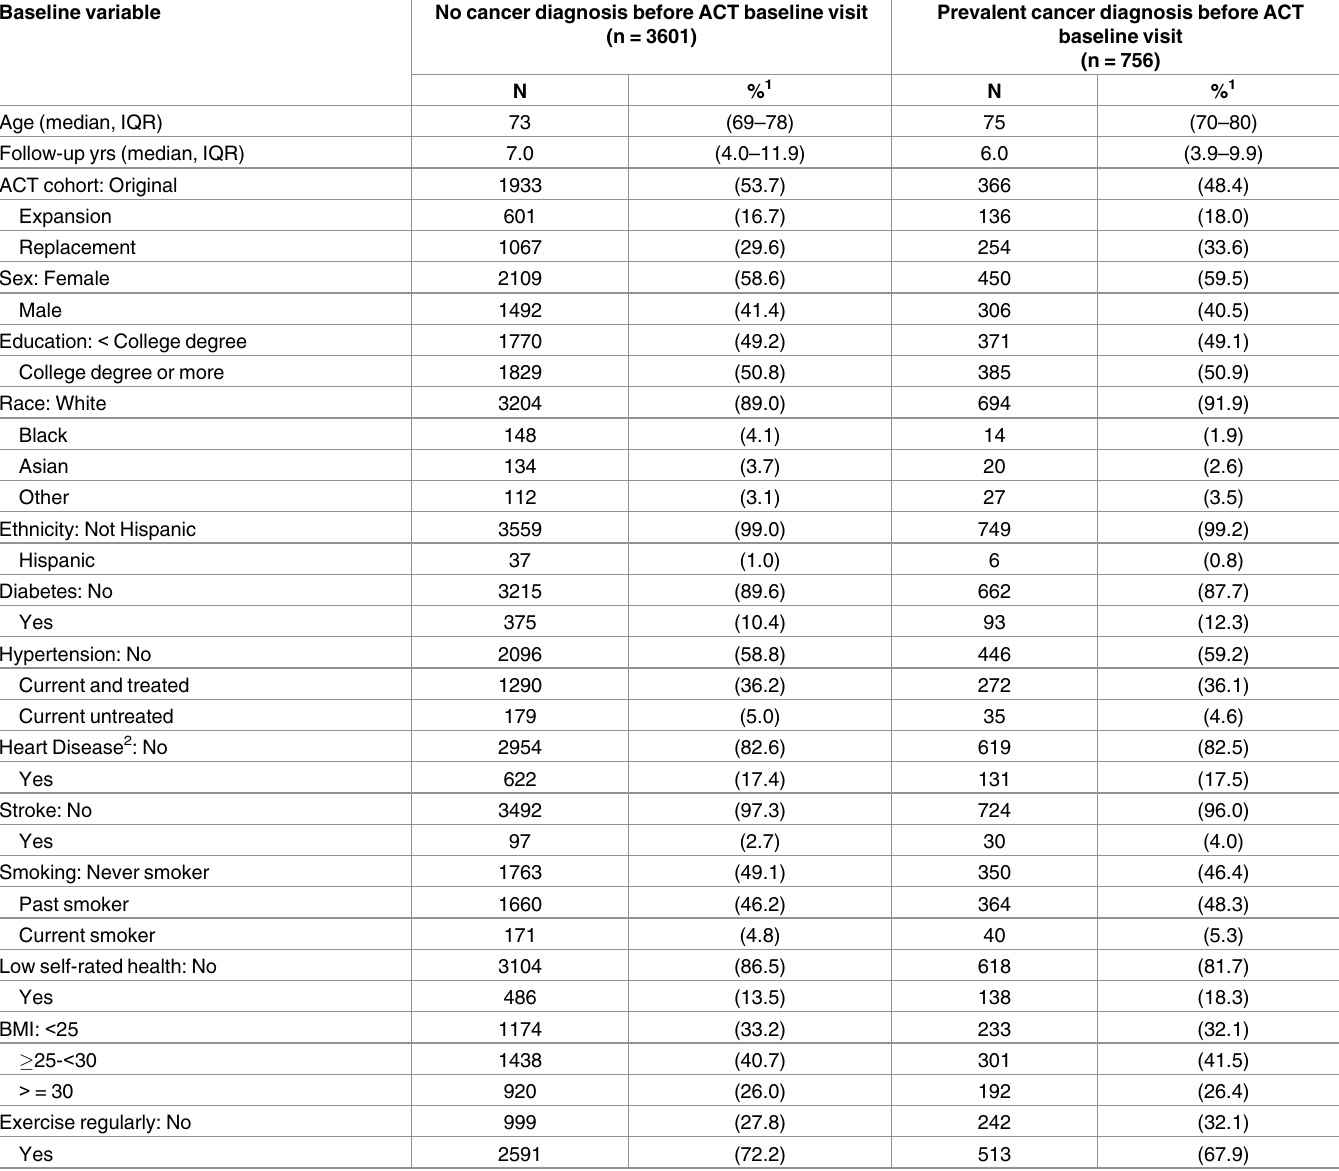
Table 1. Baseline characteristics of ACT study participants by cancer diagnoses before ACT baseline visit. This table shows distributionsof baseline demographic and health characteristics of the ACT study population,stratified by whethera person was diagnosed with any prevalentcancer at baseline. Abbreviations include: ACT (Adult Changesin Thought); IQR (interquartile range); and BMI (body mass